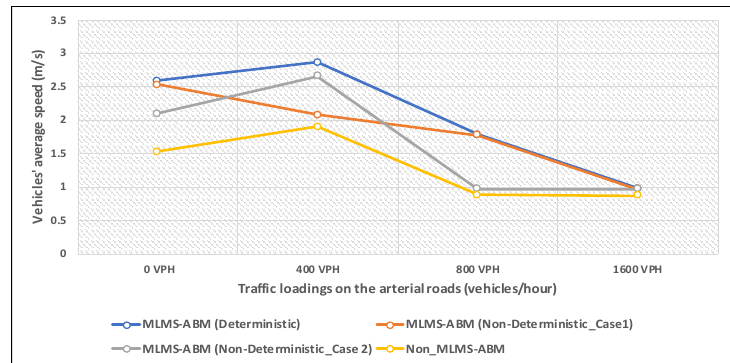
Figure 14. Vehicle’s average speed with different arterial loads (real-world network).